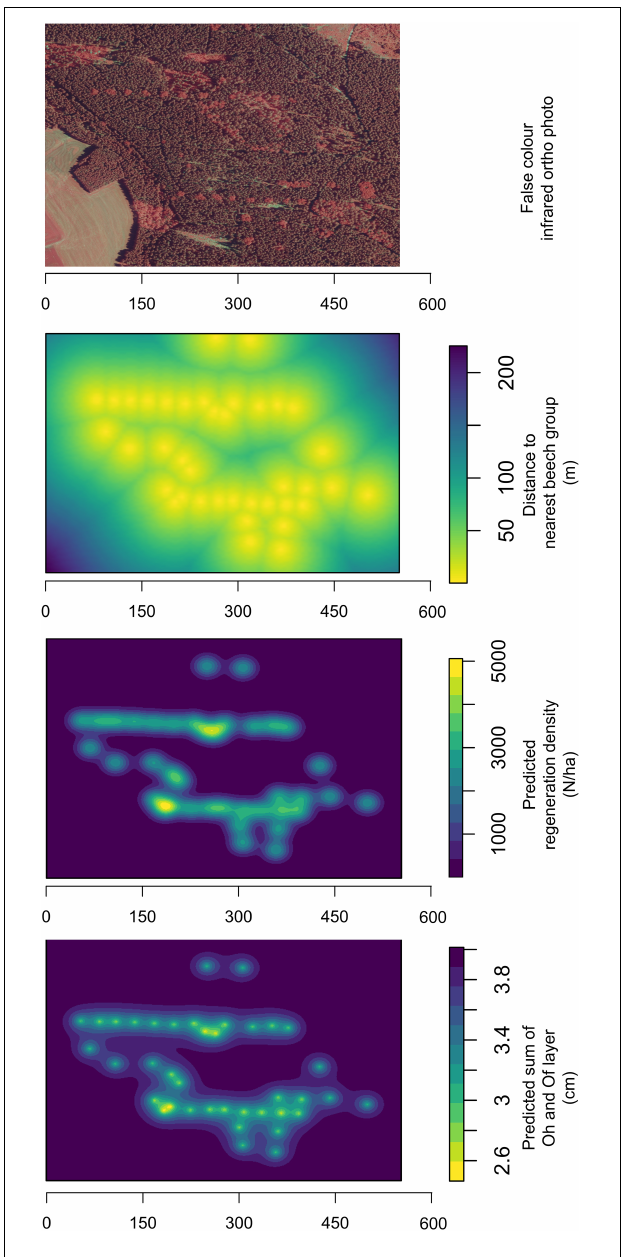
FIGURE 6 | Position of the beech groups in the spruce stands in the false-colour infrared aerial photograph in the Holzhau forest district [Map with data from GeoSN (2021)]. Distance to the nearest beech group and simulated beech regeneration density and humus thickness.